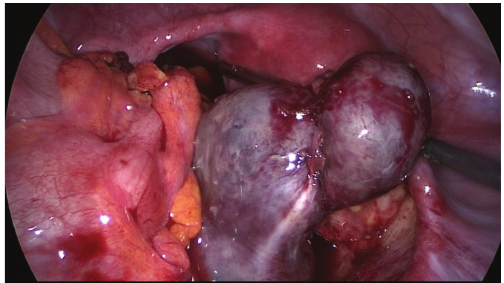
Figure 3: Fitzhung-Curtis